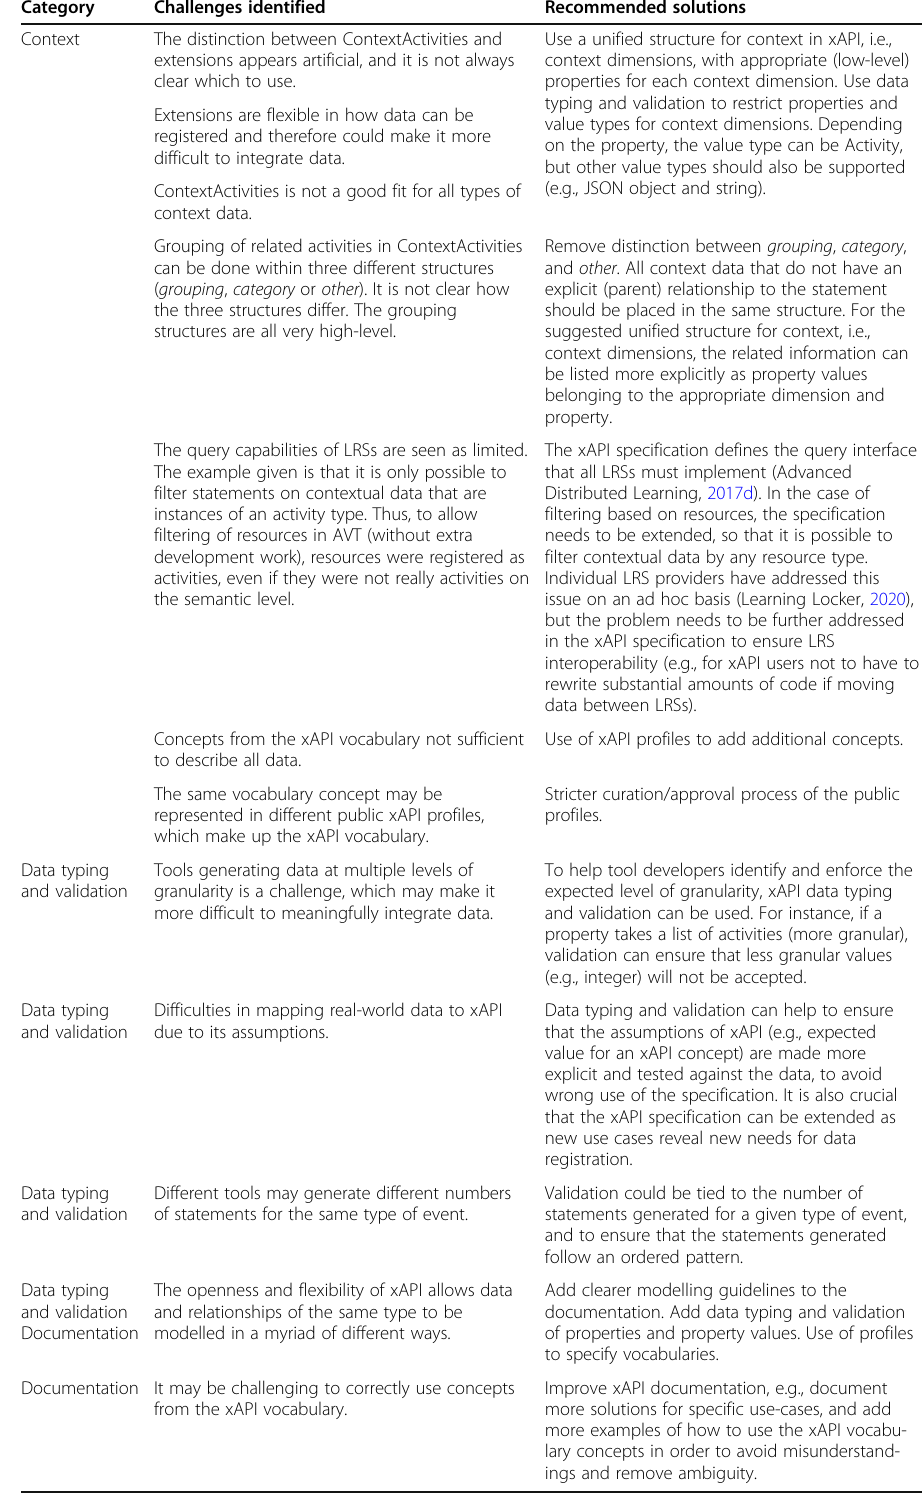
Table 4 Challenges identified and recommended